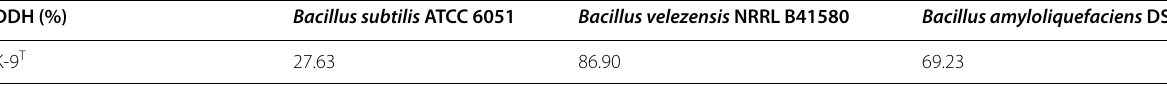
Table 5 Strain K-9 T of DNA hybridization rate with similar type strains